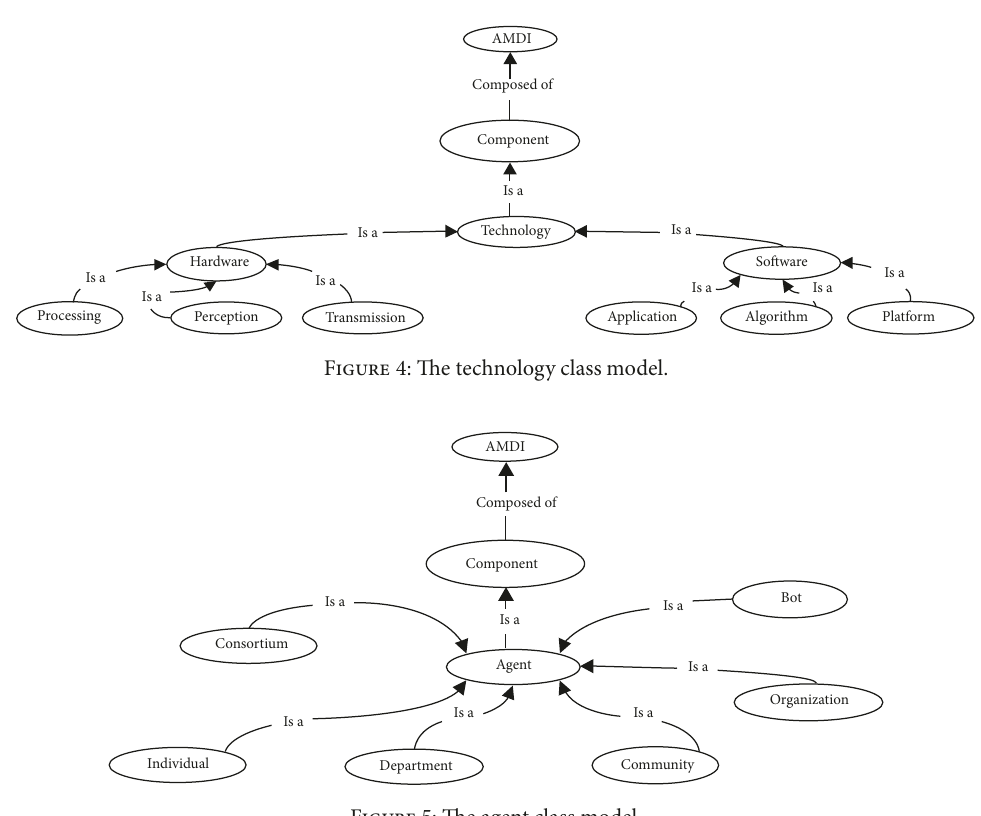
Figure 5: The agent class